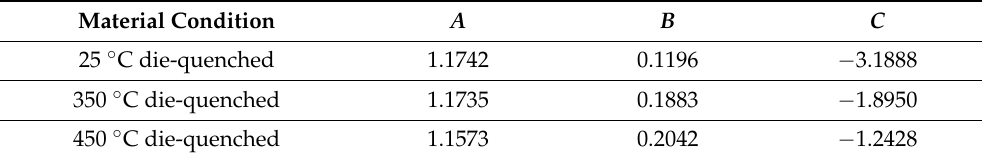
Figure 13. ( a ) Fracture loci for various die-quenched conditions of Ductibor ® 1000-AS and ( b ) a comparison between the fracture loci of Ductibor ® 500-AS [55], Ductibor ® 1000-AS, and Usibor ® 1500-AS in the cold die-quenched condition [55]. The markers denote the experimental data. Table 5. The MMC material parameters calibrated for various die-quenched conditions of Ductibor ® 1000-AS.